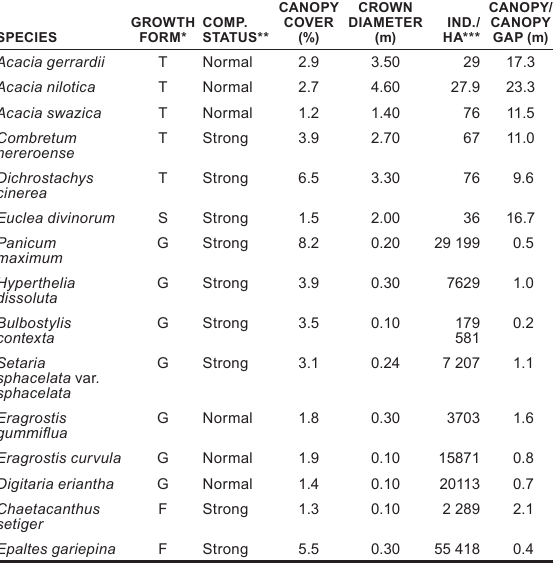
normal competitors in this hydromorphic vegetation unit (Table 8). Species growth relations within this variant are presented in Table 8 . Hyperthelia dissoluta remains a strong grass competitor (Table 8), primarily occurring towards the upper regions of this lower mid-slope vegetation unit . Epaltes gariepina is a strong forb competitor indicative of wet or seepline areas (Table 8) . Dichrostachys cinerea remains a strong